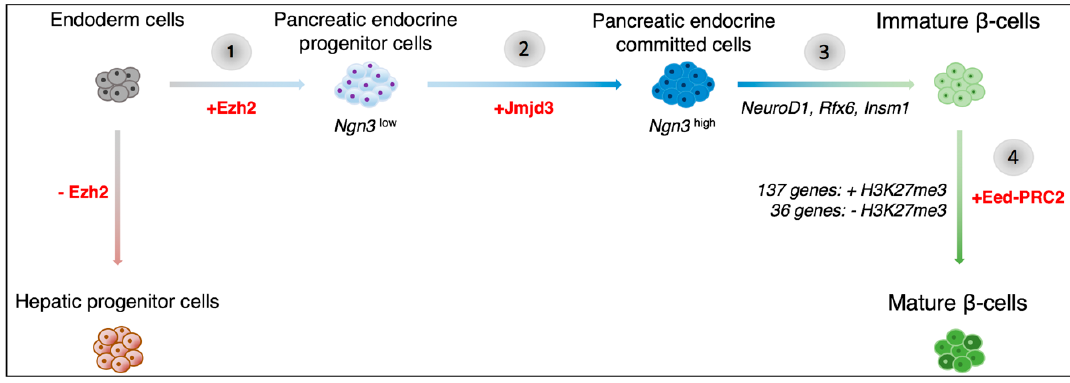
Figure 1. Schematics of the potential epigenetic mechanisms involved in pancreatic β -cell development. Previous research has shown that the transition from endoderm cells to pancreatic progenitor cells involves the activation of the Enhancer of zeste homolog 2 (Ezh2) histone methyltransferase ( 1 ). Subsequently, Neurogenin 3 ( Ngn3 ) low pancreatic endocrine progenitor cells transition to a Ngn3 high cell state and are thereby committed to the endocrine cell lineage ( 2 ). The histone demethylase, Jumonji domain-containing protein 3 (Jmjd3), was found to be involved in this process. A high level of Ngn3 expression leads to the activation Ngn3 downstream targets, such as Neurogenic differentiation factor 1 ( NeuroD1 ), Regulatory factor X, 6 ( Rfx6 ), and Insulinoma-associated 1 ( Insm1 ) ( 3 ). The resulting immature β -cells further develop through the silencing of the immaturity-associated genes (via the addition of H3K27me3 marks) and the de novo activation of maturity-associated genes (with the loss of H3K27me3 marks) ( 4 ). The epigenetic changes associated with this stage in development are regulated by the polycomb repressor complex (EeD-PRC2).